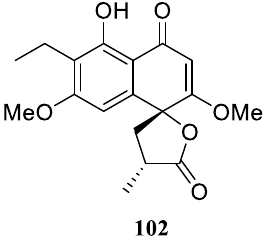
Figure 44. Perenniporide A, the only spirocyclic lactone of the perenniporide family.